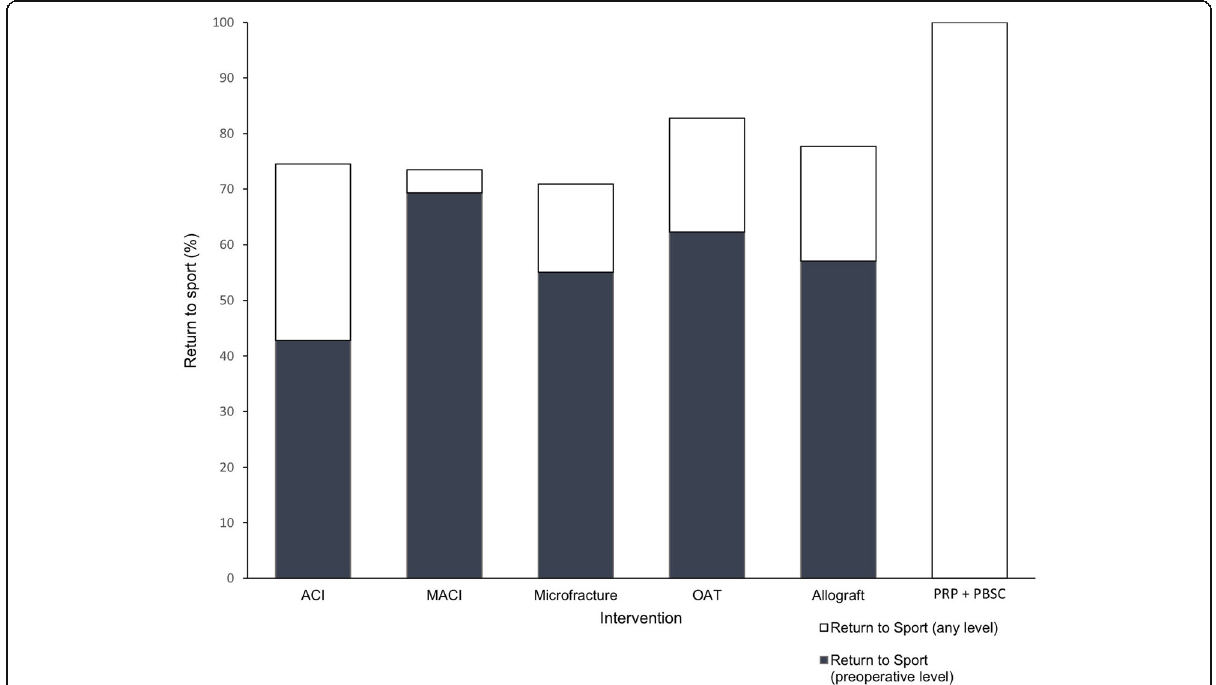
Fig. 3 Proportion of patients returning to sport and returning to the same preoperative level of